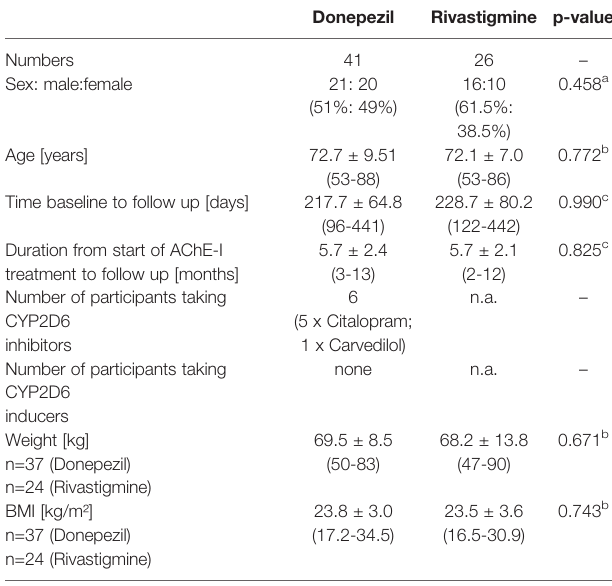
TABLE 1 | Characteristics of participants: where applicable: mean ± standard deviation (minimum - maximum).